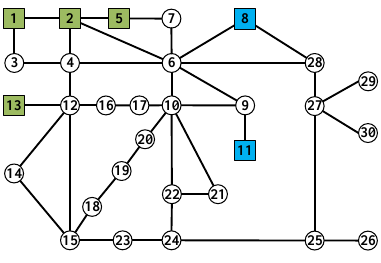
Figure 3. The graph of the 30-node